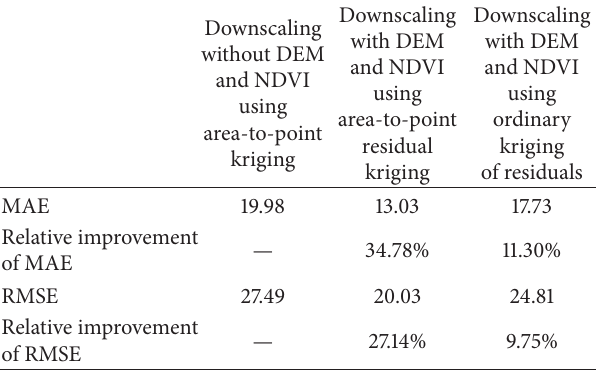
Figure 6: Simulation results: (a) 1st realization and (b) 10th realization. Table 1: Predictive performance evaluation